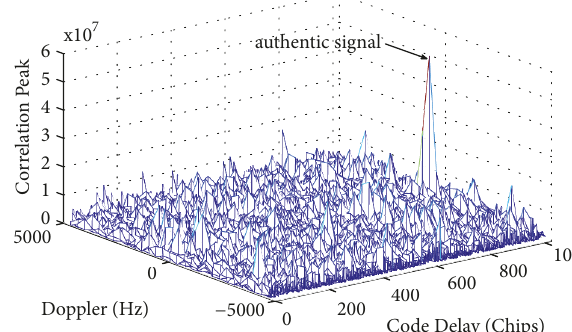
Figure 6: Acquisition of PRN25 with SP.